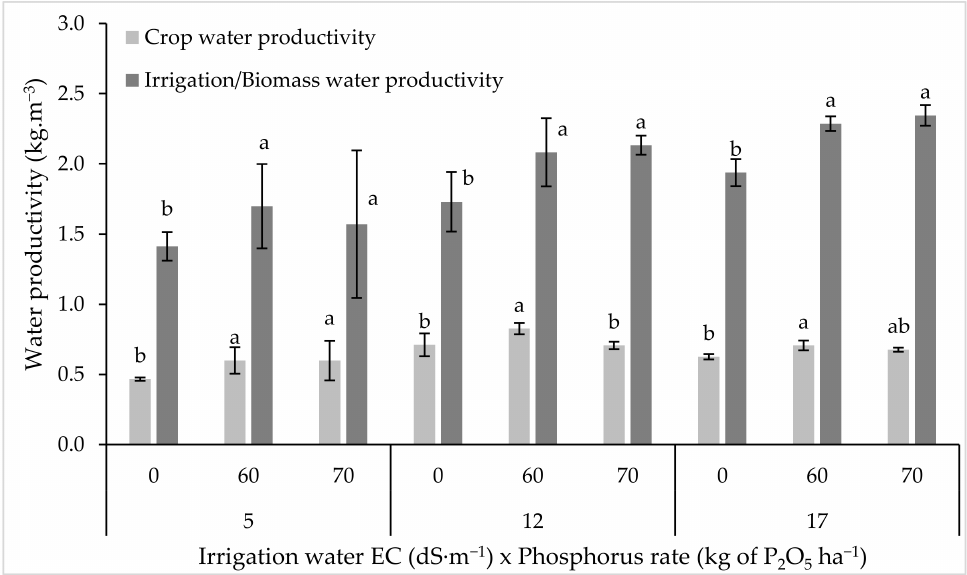
Figure 2. Variation in crop and irrigation water productivity under different phosphorus fertilizer rates and irrigation water salinities. Any two values within a column are significantly different ( p ≤ 0.05) if they have no letter in common. The same letters indicate the statistically homogeneous groups. Error bars indicate the standard